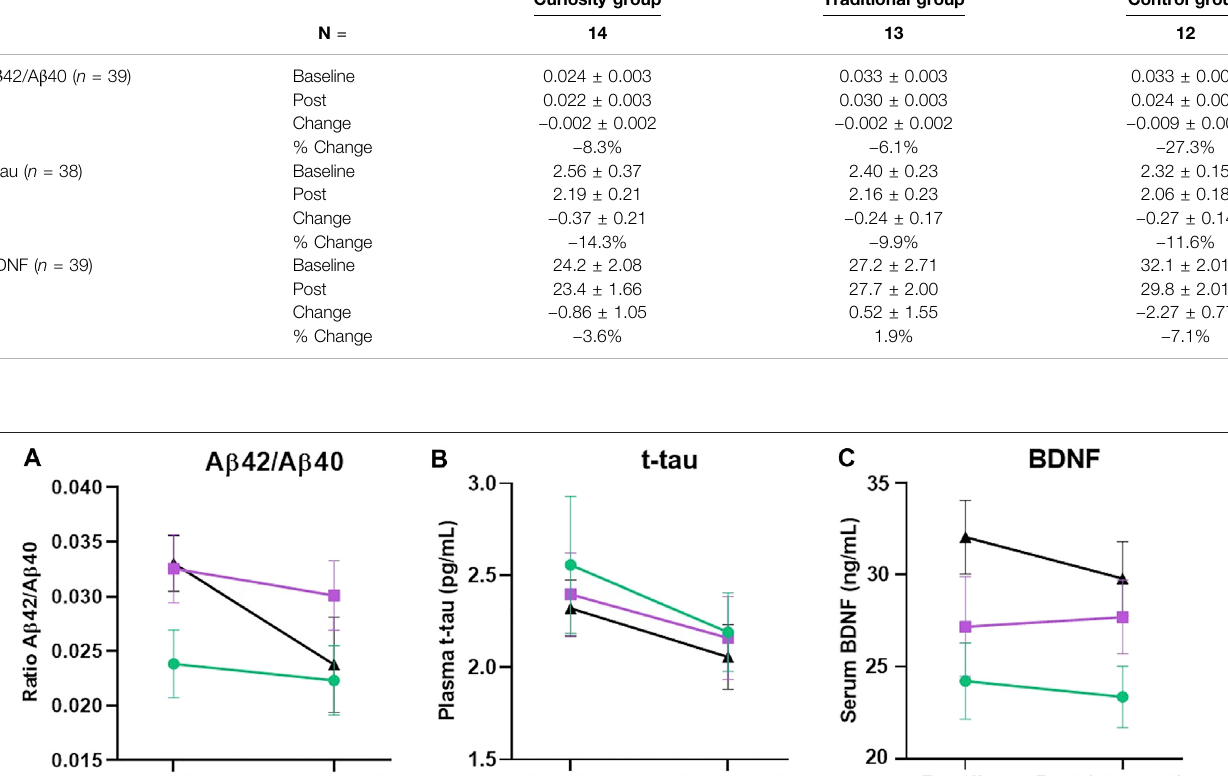
TABLE2| ChangesinbiomarkersofAD(ratioA β 42/A β 40,t-tauandBDNF)inthethreestudygroups . Valuesfort-tauaregiveninpg/mLandvaluesforBDNFaregiveninng/ mL. Results are presented as mean ± SEM or percentage (%). Curiosity group Traditional group